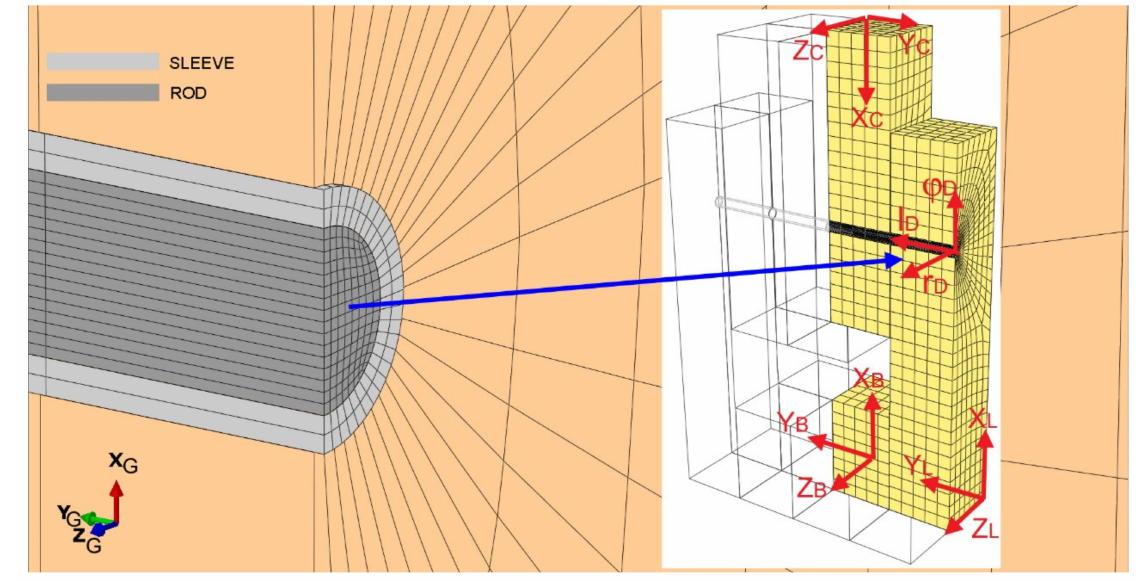
Figure 7. Finite element